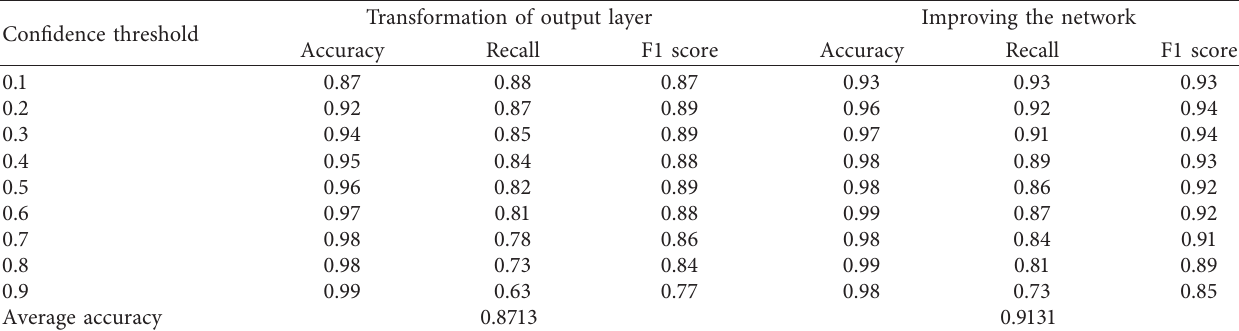
Table 1: Model performance under different confidence thresholds.